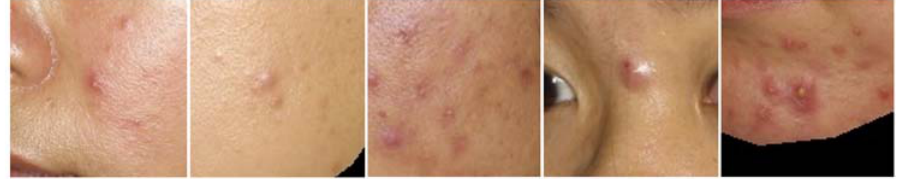
Figure 2. Different appearances of acnes.